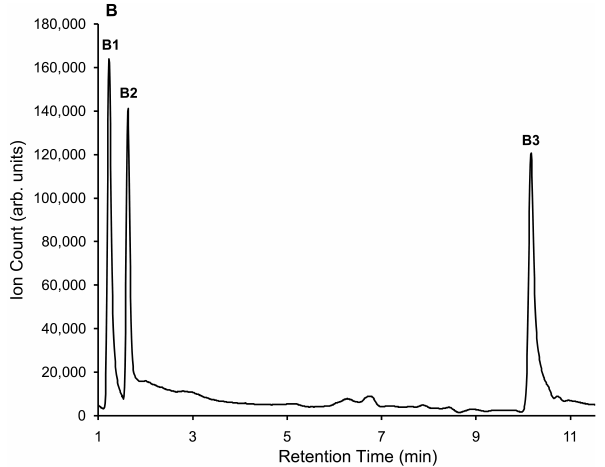
Fig. 4b. Chromatogram of X-NH 2 compound mixture in H 3 PO 3 derivatized with 2-furaldehyde analyzed by LC/MS. (B1) , methyl- hydrazine ( m/z 125, N-methylhydrazone); (B2) , hydroxylamine ( m/z 112, oxime); (B3) , hydrazine ( m/z 189,